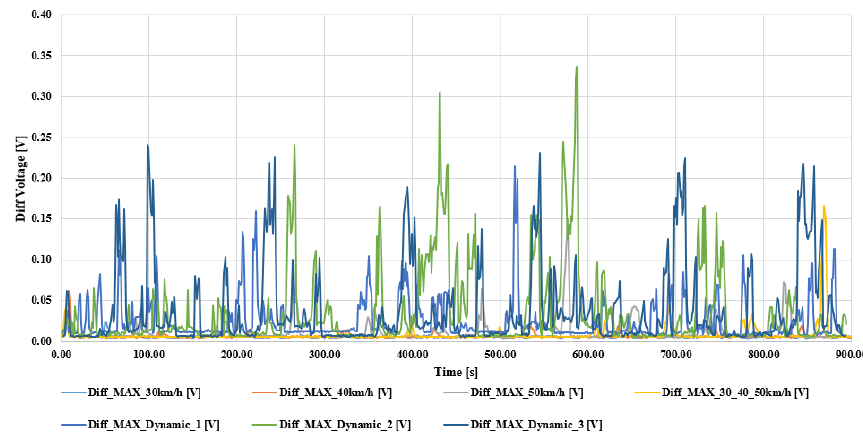
Figure 9. Deviation from the average voltage under different loads.